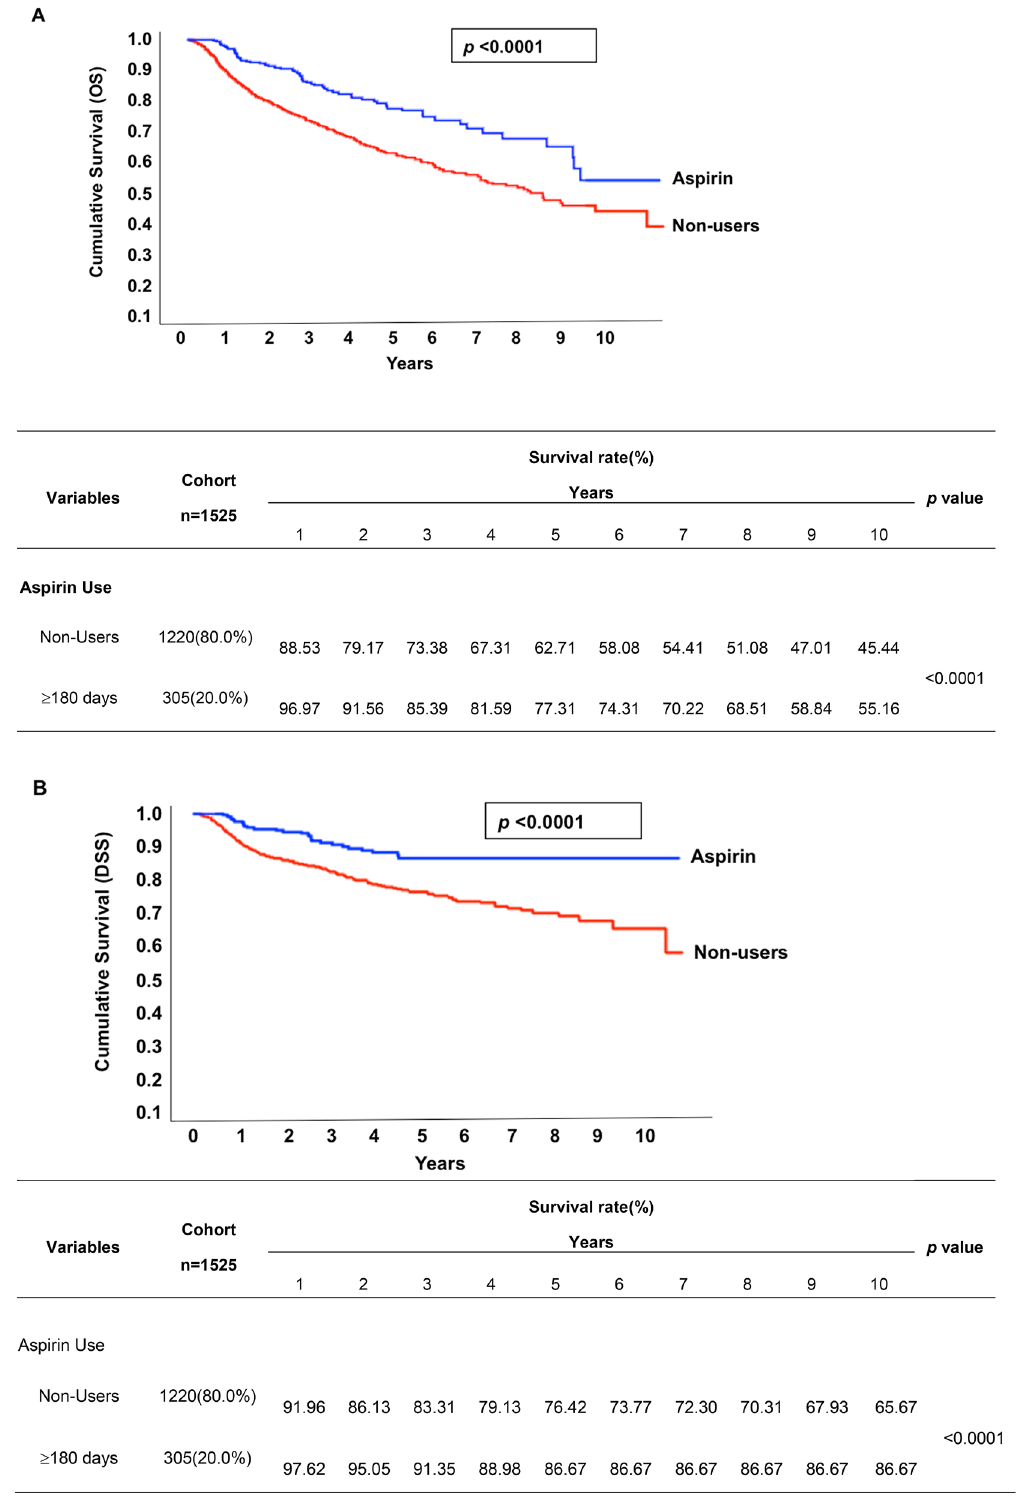
Figure 2. Kaplan–Meier survival curve of OS and DSS rates between aspirin users (≥ 180 days) and non- users. ( A ) The median OS rate of non-users was around 8 years and the estimated 10-year OS rate was 45.44%. Although median survival was not reached for aspirin users (≥ 180 days), estimated 10-year OS rate was 55.16%. ( B ) The estimated 10-year DSS rate of non-users was 65.67%, whereas aspirin users (≥ 180 days) was